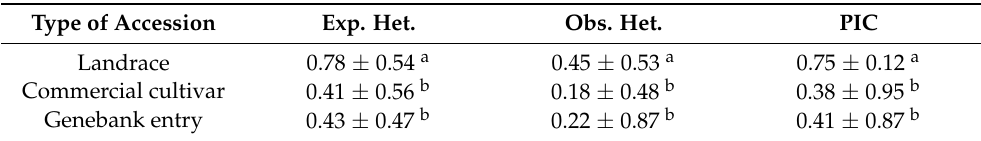
Table 2. Average expected heterozygosity and polymorphism information content (PIC) values as well as average observed heterozygosity for the accessions of purple passion fruit ( P. edulis f. edulis ), grouped according to their origin.